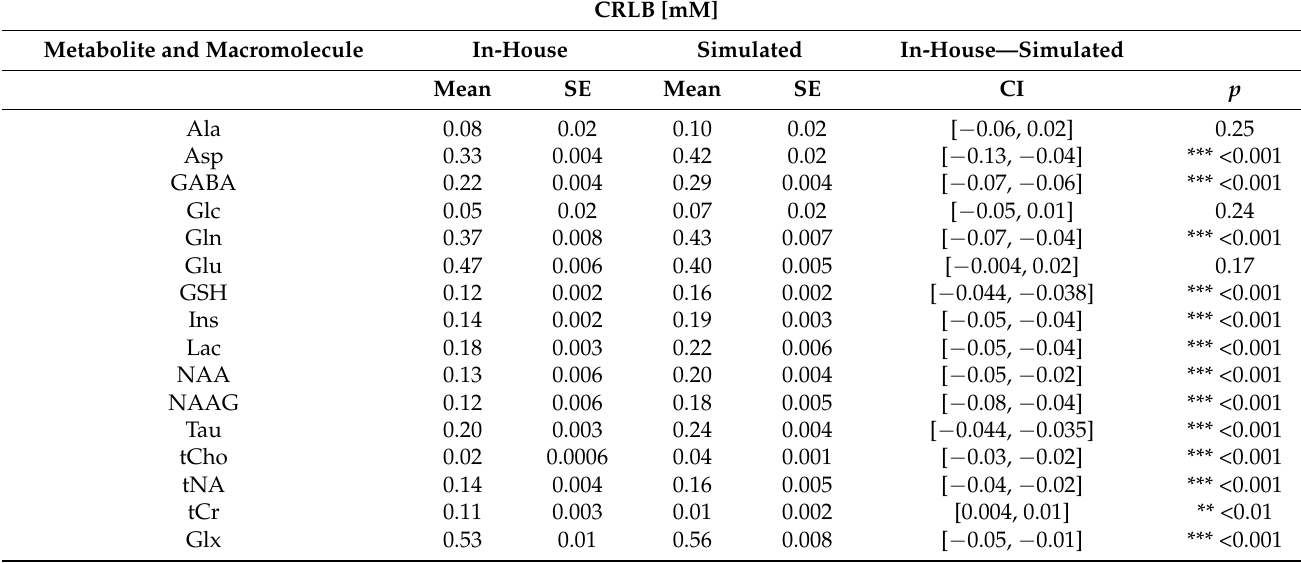
Table 1. CRLBs of metabolites and macromolecules and comparison of group difference by paired t